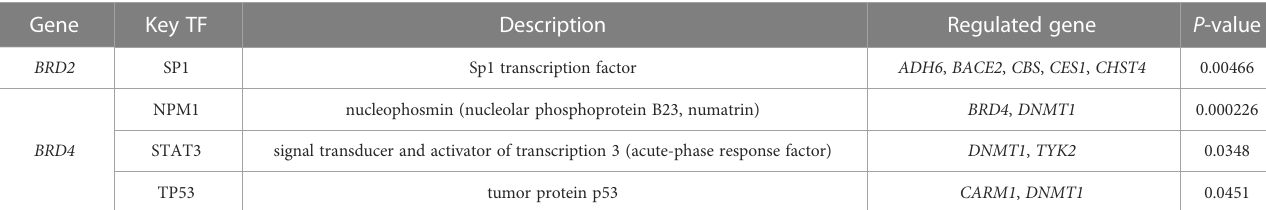
TABLE 4 Key regulated factor of BET family and the top 50 neighbor altered gene in ACC (TRRUST). Gene